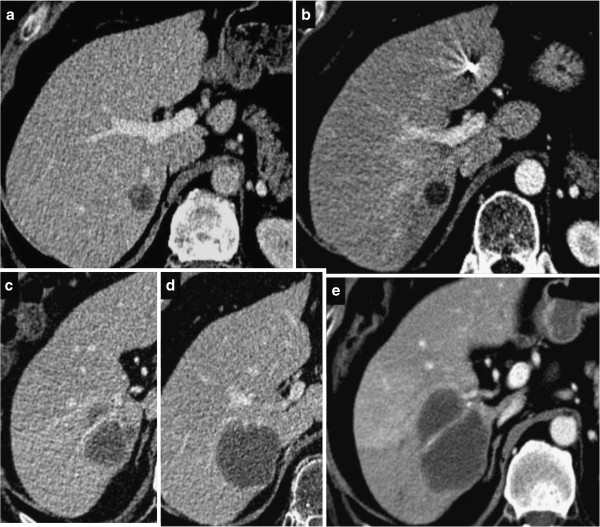
Pseudo- progressive lesion after SBRT, before treatment (a), 2 months later (b), 6 months later (c, d), and 9 months later (e). CT slices show the progressive size increase with a completely necrotic lesion.